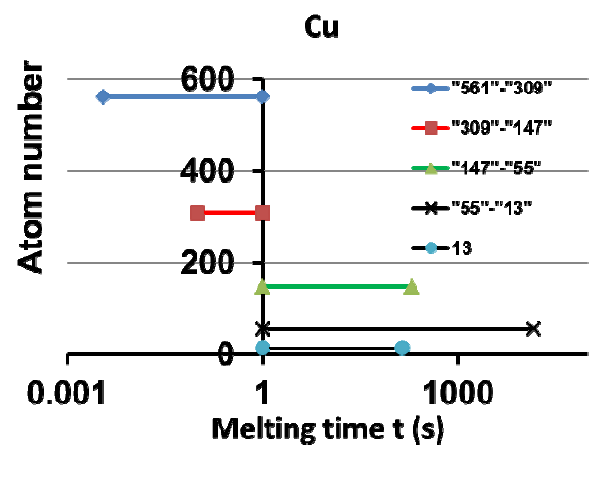
Figure 17. Chain melting of superclusters versus superheating time. The first cluster to be melted at θ = 0.086 contains 13 atoms, the next ones 55, 147, 309 and 561 because the liquid droplet grows in the core of the largest